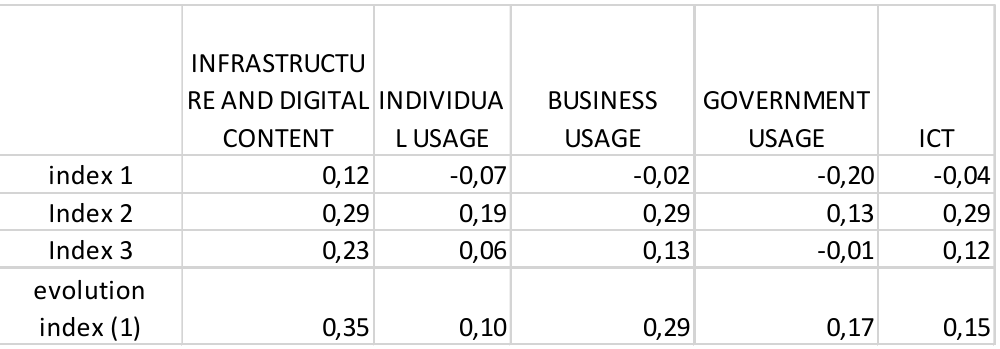
Table 1: Correlations amongst Concentration Indexes and Different Indicators of Propensity to Internet, Different Countries, 2012